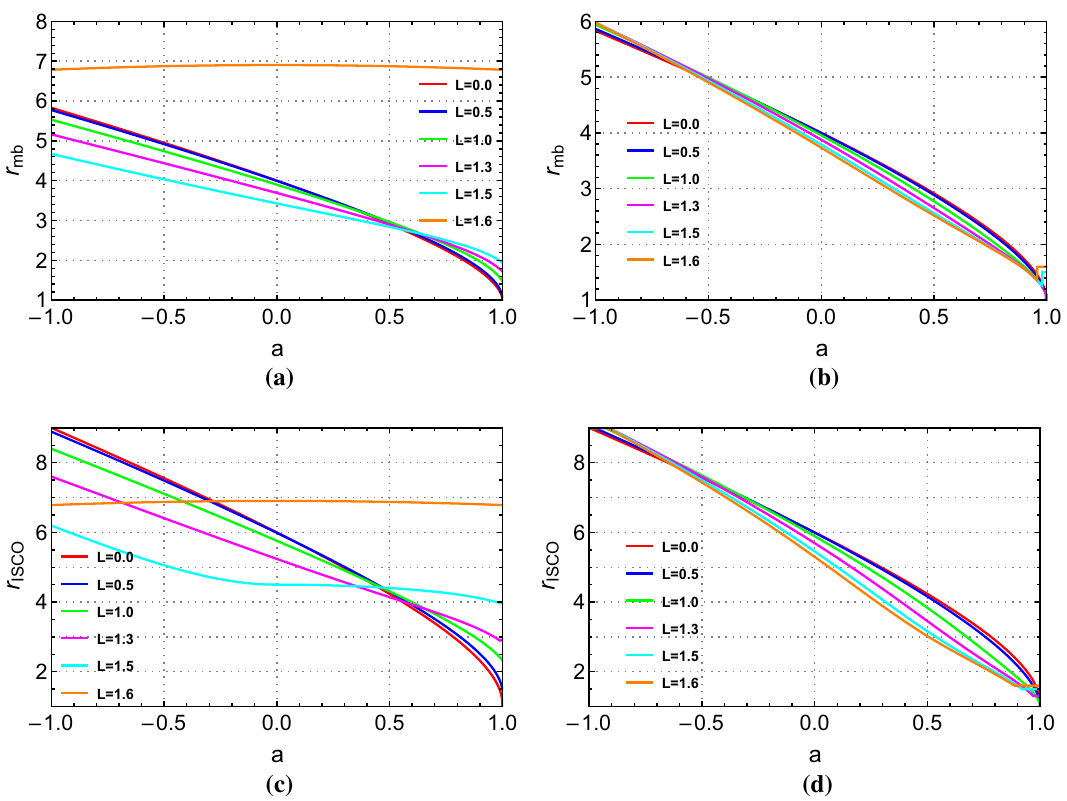
Fig. 2 a Radius of marginally bound orbits as a function of the black hole spin and for L varying from 0 to1.6 in the regular blackhole space- times. b As in a for the singular black hole solutions. c ISCO radius